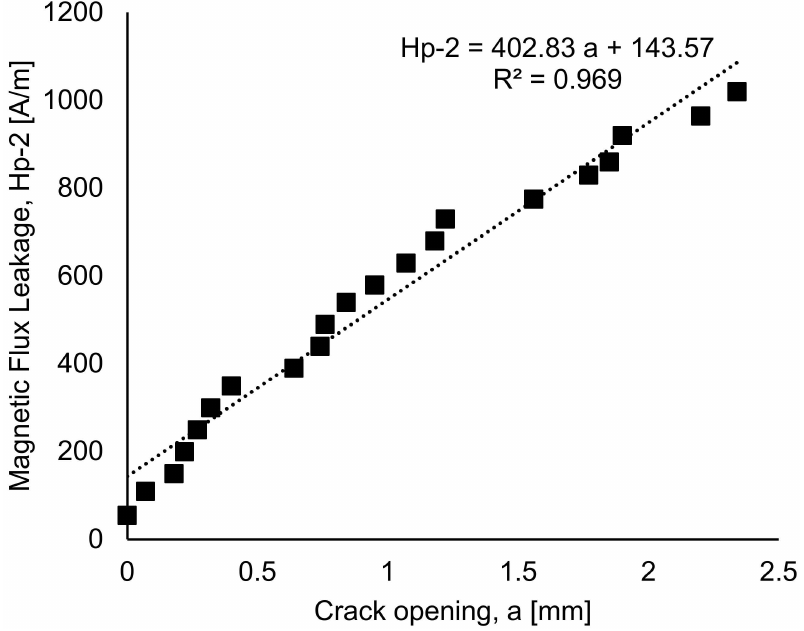
Figure 13. The correlation between magnetic flux leakage and the crack